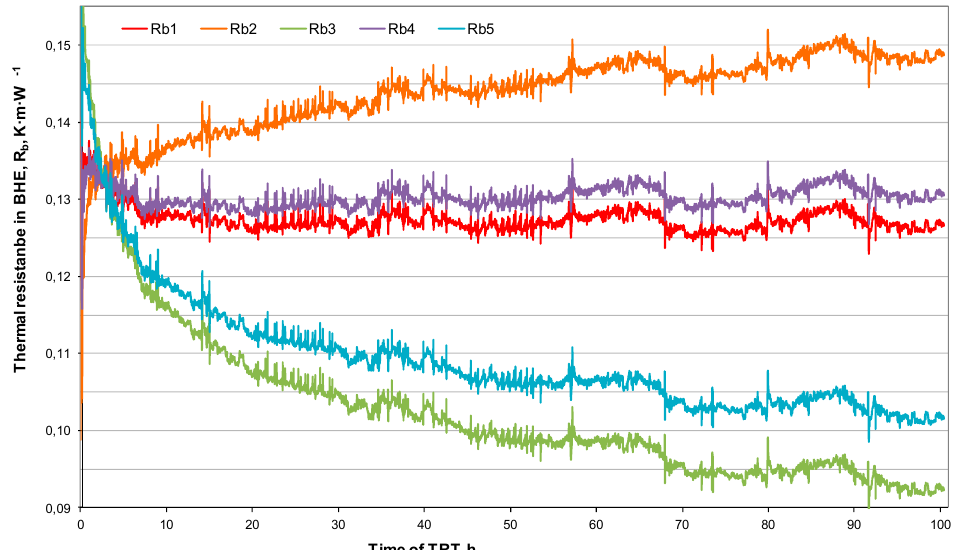
Figure 5. Thermal resistivity of BHE vs. TRT time, where R b 1 , R b 2 , R b 3 , R b 4 , and R b 5 are described in the text.